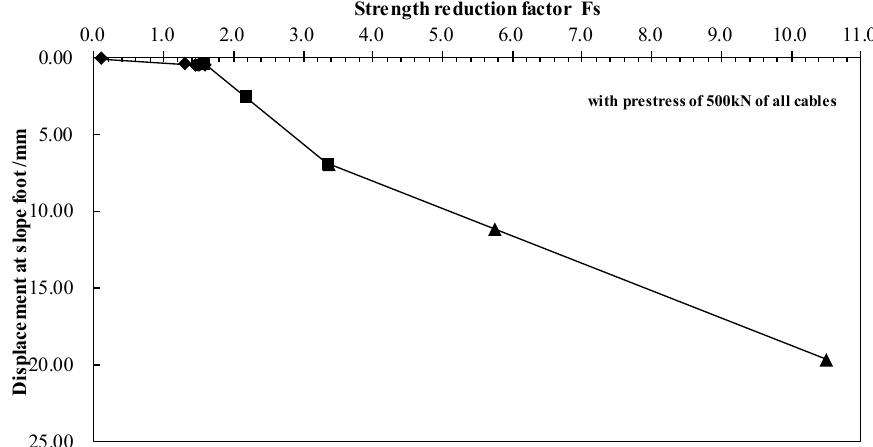
Figure 5. The relationship between the displacement of slope foot strengthened by prestressed anchor cables and the strength reduction factor (obtained by the convergence method).